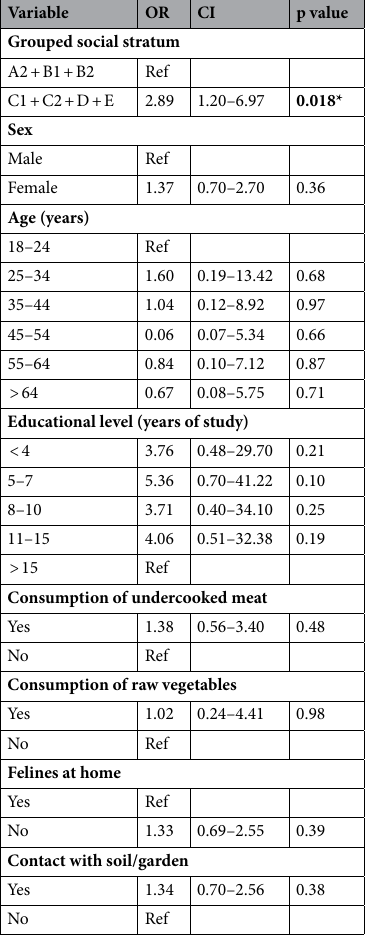
Table 3. Results of binary logistic regression between study variables and ocular toxoplasmosis (n = 721 subjects). Social categories classified according to the Brazilian Association of Research Companies (ABEP) 21 , being high (A1, A2, B1, B2) and low (C1, C2, D, and E) social stratum; (*) and bold, statistically relevant. Social stratum "E" composed of only two subjects, one with eye damage and the other without lesion. Ref.: group used as a reference; CI: Confidence interval; OR: odds ratio.